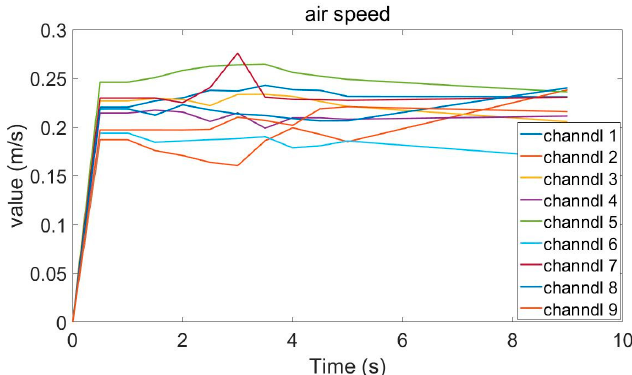
Figure 13. Wind speed profiles of simulation.